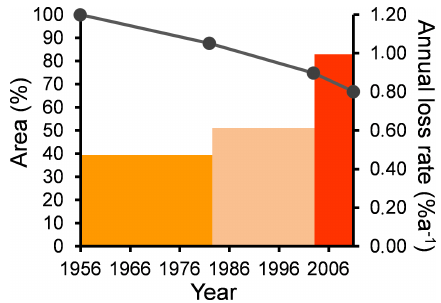
Figure 9. Areal extent of palsas and peat plateaus in Suossjavri rel- ative to the area in 1956 (dots) and mean annual loss rates (bars) for the different time